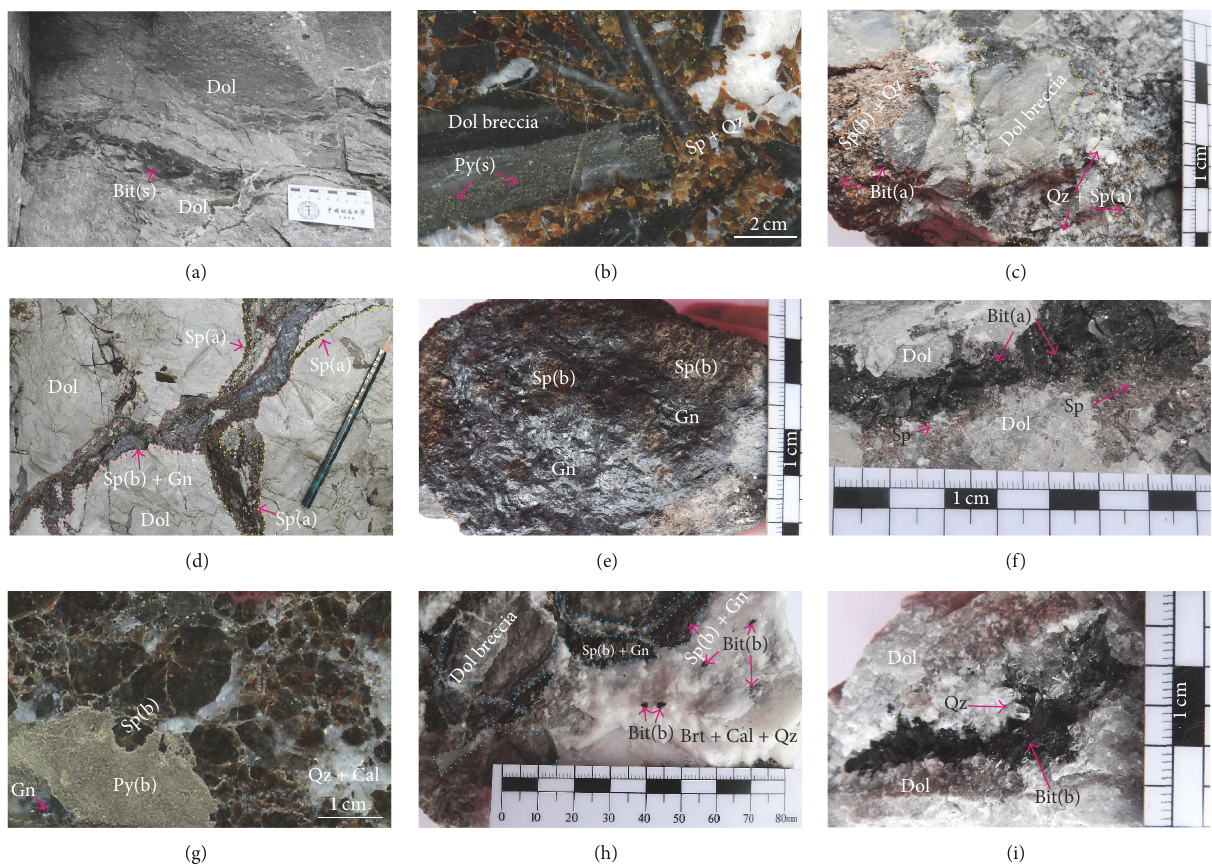
Figure 4: Photographs of mineralization characteristics of the Nanmushu Zn-Pb deposit. (a) Vein-type bitumen (Bit(s)) occurs parallel to the country rock. (b) Breccia-type ore, dolomite breccia with Py(s) cemented by later hydrothermal mineral. (c) Breccia-type ore, yellow sphalerite + quartz (stage I) and brown sphalerite + quartz (stage II) are cemented by the dolomite breccia. (d) Vein-type ore, assemblages of coarse-grained galena with minor sphalerite as a vein (stage II) crosscut the early sphalerite vein (stage I). (e) High-grade massive ore, assemblages of coarse-grained galena and sphalerite (stage II). (f) Bit(a) associating with contemporary sphalerite occurs in vein (stage II). (g) Later Py(b) surround the early Sp(b) in stage II. (h) Sphalerite and galena as breccia (stage II), cemented by late barite + calcite + quartz + bitumen (stage III). (i) Abundant Bit(b) filled in the interspace of quartz in stage III. Bit, bitumen; Brt, barite; Cal, calcite; Dol, dolomite; Gn, galena; Py, pyrite; Qz, quartz; Sp, sphalerite.